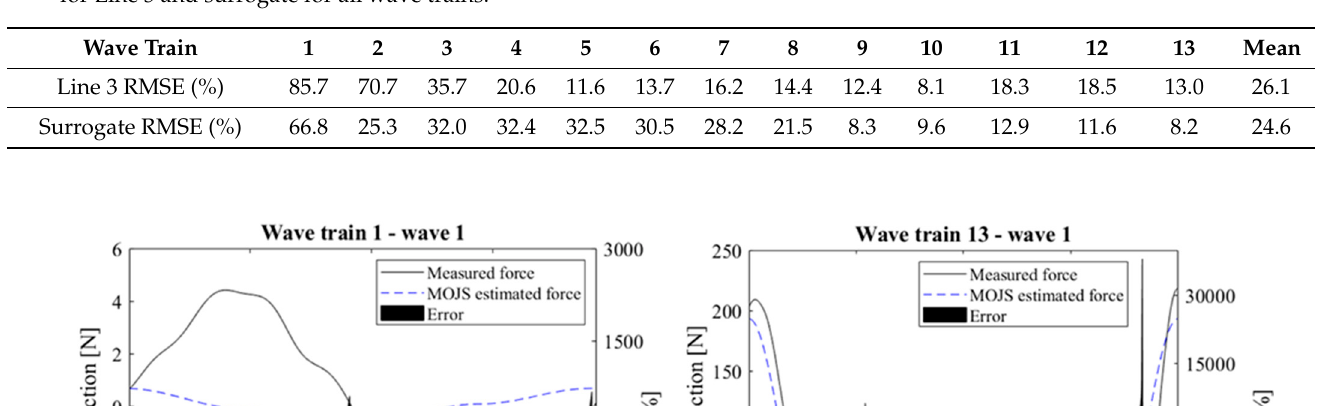
Figure 11. Drag coefficients related to the Keulegan–Carpenter ( KC ) number for the live lines and the surrogate. The mean RMSE (Equation (3)) of the measured and MOJS approximated force peaks, using the experimentally determined drag coefficients, are listed exemplarily for line 3 and the surrogate in Table 5. RMSE decreases from wave train 1 to wave train 13 for all lines; RMSE of force peaks of wave train 1 is 3.1 to 9.5 times higher than the RMSE of force